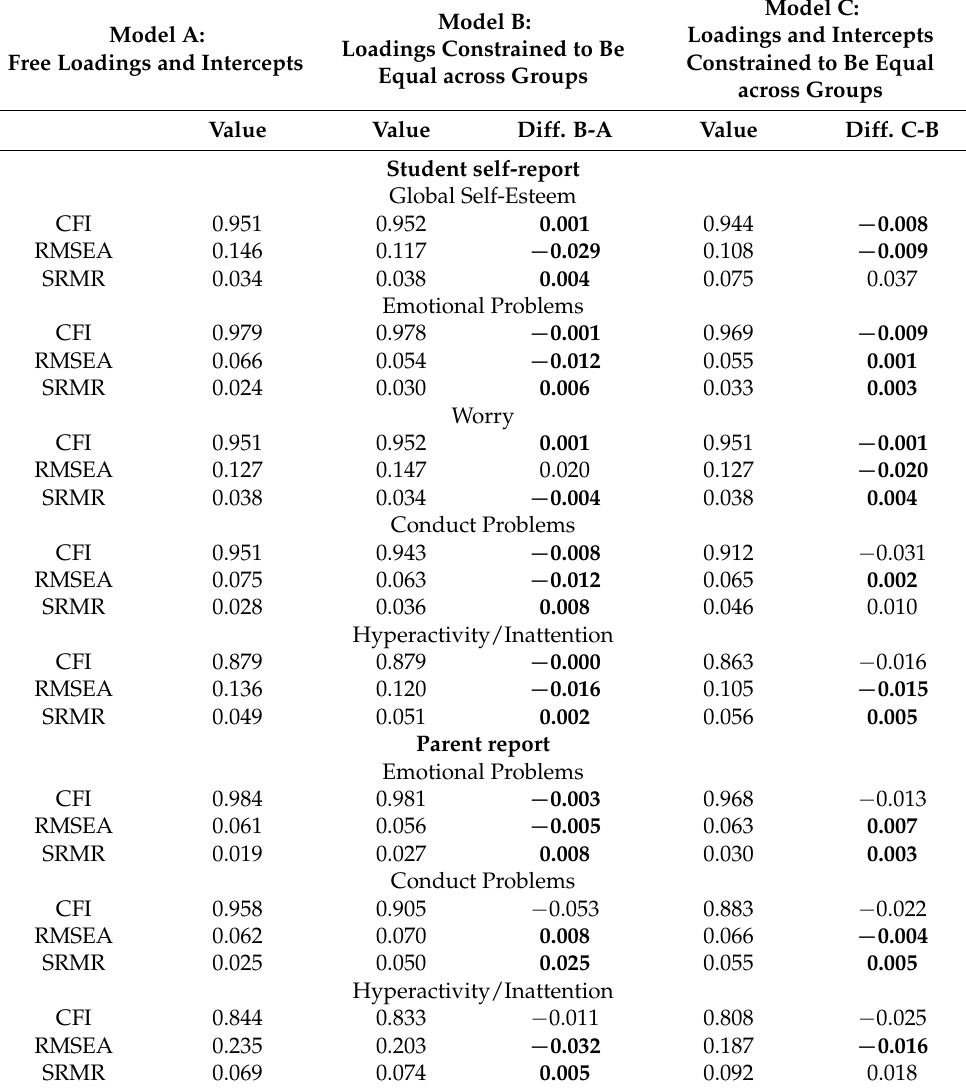
Table 1. Measurement invariance of mental health indicators between high ability (IQ ≥ 120) and average ability (90 ≤ IQ ≤ 110) adolescents. Difference values in bold indicate that the observed changes in model fit supported measurement invariance (decrease in CFI ≤ 0.010; increase in RMSEA ≤ 0.010; increase in SRMR ≤ 0.025 (metric invariance) or ≤ 0.005 (scalar